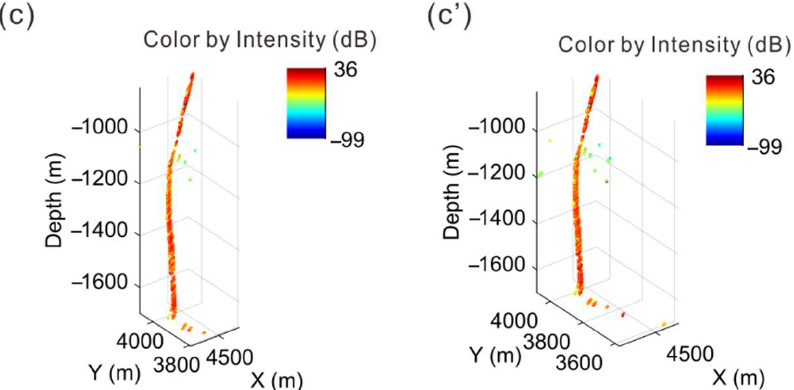
Figure 17. DBSCAN clustering versus Euclidean distance clustering. ( a , a’ ) are the results of DBSCAN and Euclidean distance XOY spatial point cloud clustering, respectively. The DBSCAN clustering method enables the identification of the point cloud noise points (blue dots) based on density while the Euclidean distance clustering method can only contribute to partitioning them into different clusters; ( b , b’ ) are the comparison of the DBSCAN and Euclidean distance algorithm after spatial point cloud clustering, respectively; different colors represent different point cloud clusters identified by the algorithm, where the DBSCAN algorithm in ( b ) directly removes the identified noisy points and the Euclidean distance clustering removes the point clouds that cannot form clusters; ( c , c’ ) are the point cloud clusters containing plumes extracted by the DBSCAN and Euclidean distance algorithm, respectively, and it can be seen that the plumes extracted by the DBSCAN algorithm contain less spatial point cloud noise.